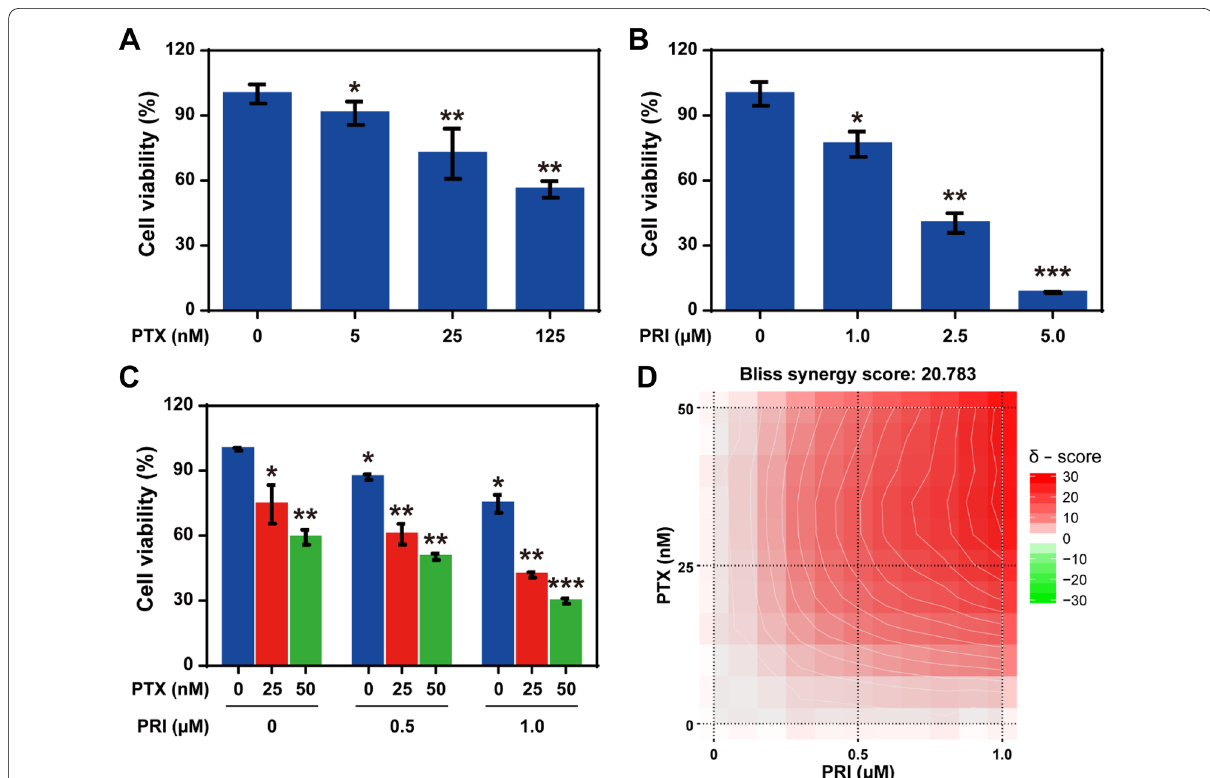
Fig. 2 Synergistic inhibitory effects of PRI and PTX on cell viability of A549 cells. A Cell viability of A549 cells treated with different concentrations of PTX (n 3). B Inhibition of cell viability on A549 cells treated with PRI (n = The synergistic score of PTX combined with PRI calculated by using the Synergyfinder 2.0 software. *: P < 0.05. **: P < 0.01. ***: P <